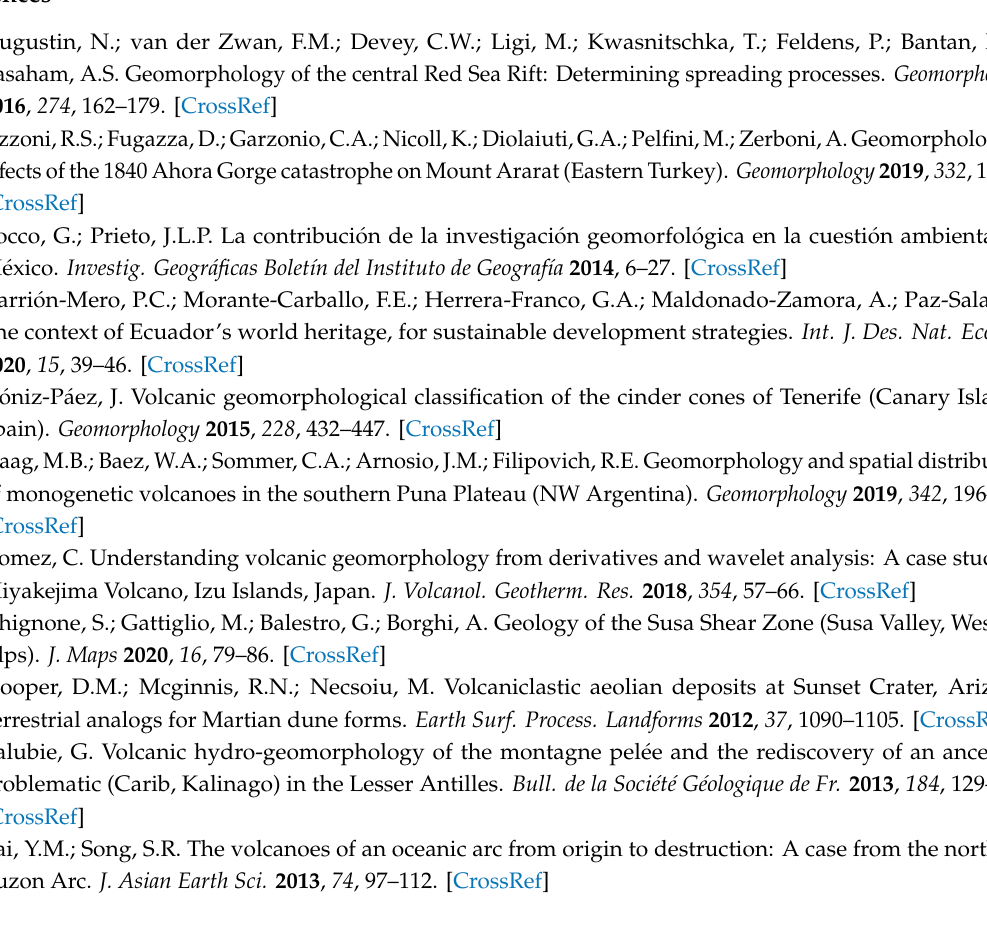
Table S1: Detail of the Keywords with the highest Co. occurrence, Table S2: Detail of the authors with the highest Co. citation, Table S3: Detail of the journals with the highest number of